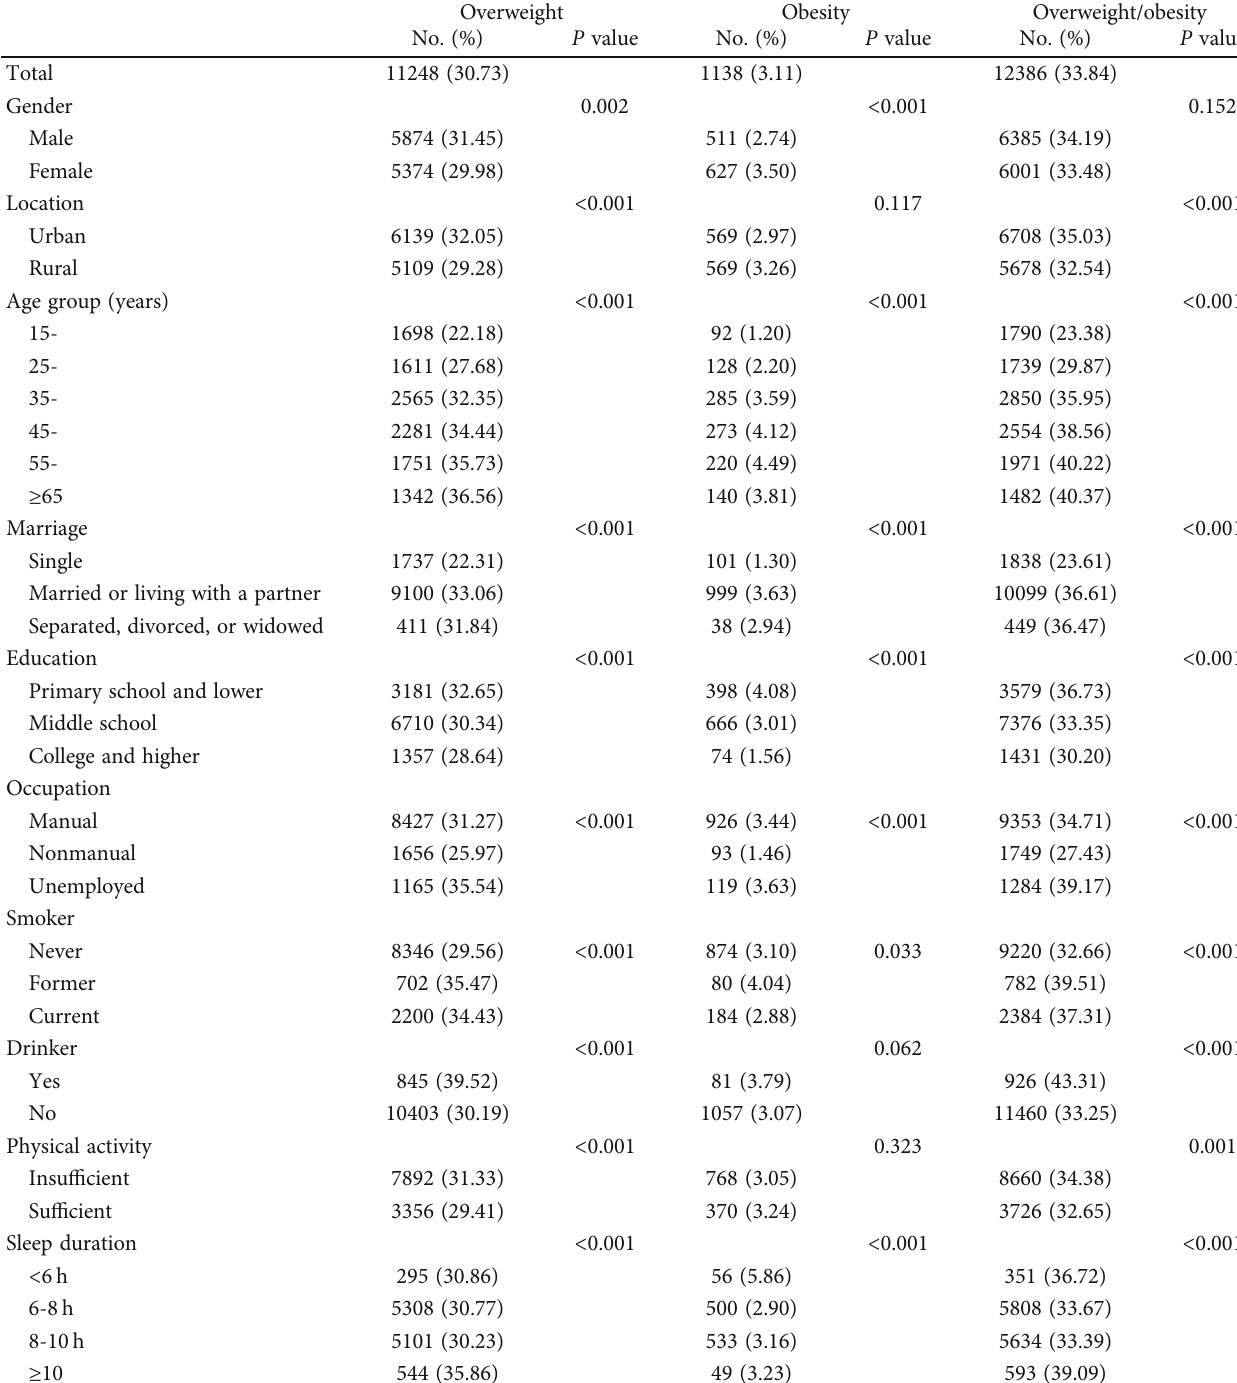
Table 2: Prevalence of overweight and obesity among various characteristics.